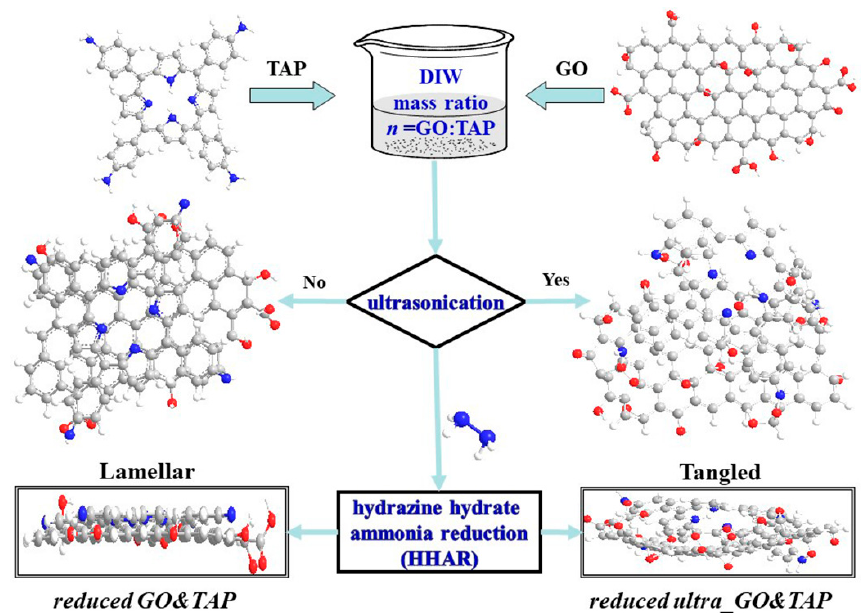
Figure 1. The experimental protocol for preparing tetra (4-aminophenyl) porphyrin (TAP) and reduced graphene oxide (rGO) hybrid for the channel film of the rGO-based field effect transistors (rGO-FETs). The precursors are the mixture of GO and TAP (GO&TAP) in deionized water with mass ration ( n = GO:TAP) and the ultrasonically treated one (named as ultra_GO&TAP), respectively. After being reduced by the similar hydrazine hydrate and ammonia reduction (HHAR), their products are named as reduced GO&TAP, reduced ultra_GO&TAP, respectively.